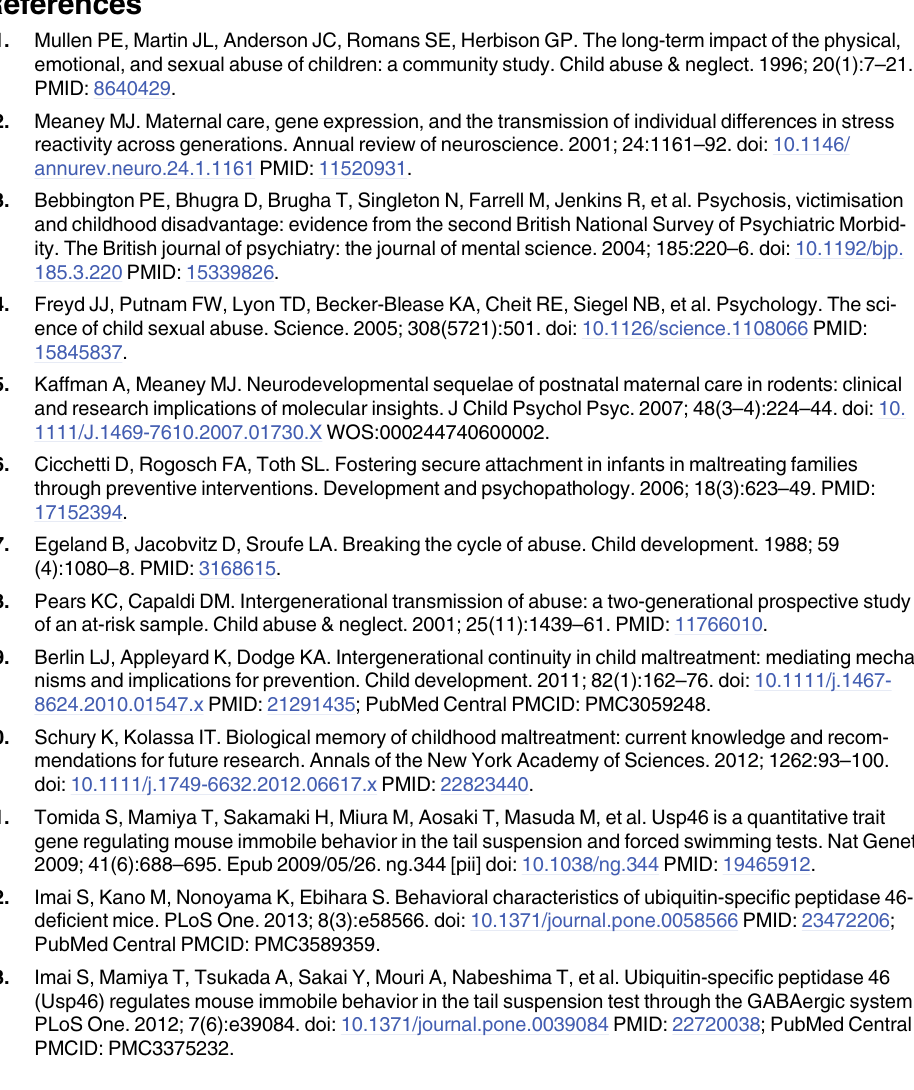
S3 Fig. Survival rate of B6 and MT mice during the nursing period. The survival rate of MT mice dramatically decreased within 3 days of parturition. The number of mice used is shown